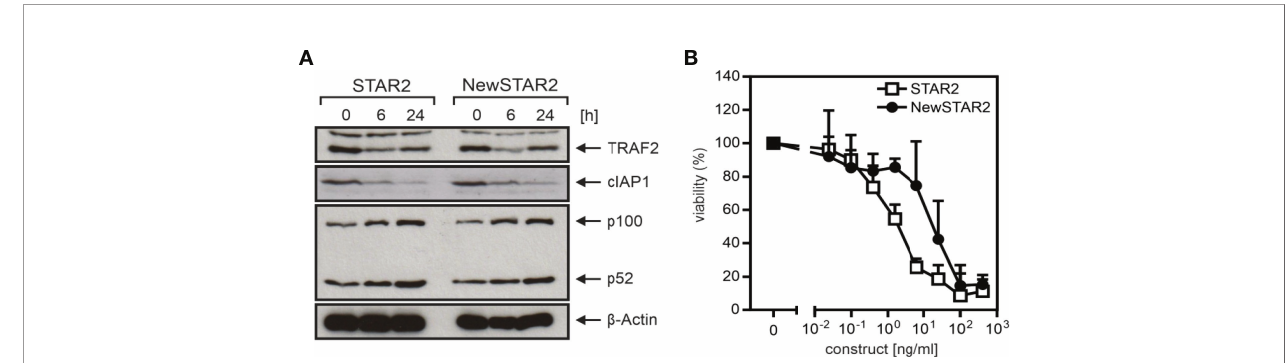
FIGURE 2 | In vitro activity of TNFR2-selective muTNF fusion proteins. (A) Macrophages differentiated from Hoxb8 immortalized murine MPCs were stimulated overnight with 200ng/ml of STAR2 or NewSTAR2 and total cell lysates were analyzed by western blotting for the presence of the indicated proteins. One representative experiment of 3 is shown. (B) Macrophages were stimulated with the indicated concentrations of STAR2 or NewSTAR2 in the presence of 20 m M Z-VAD-FMK. After 36h cell viability was evaluated. Data shown are averaged from 3 independent